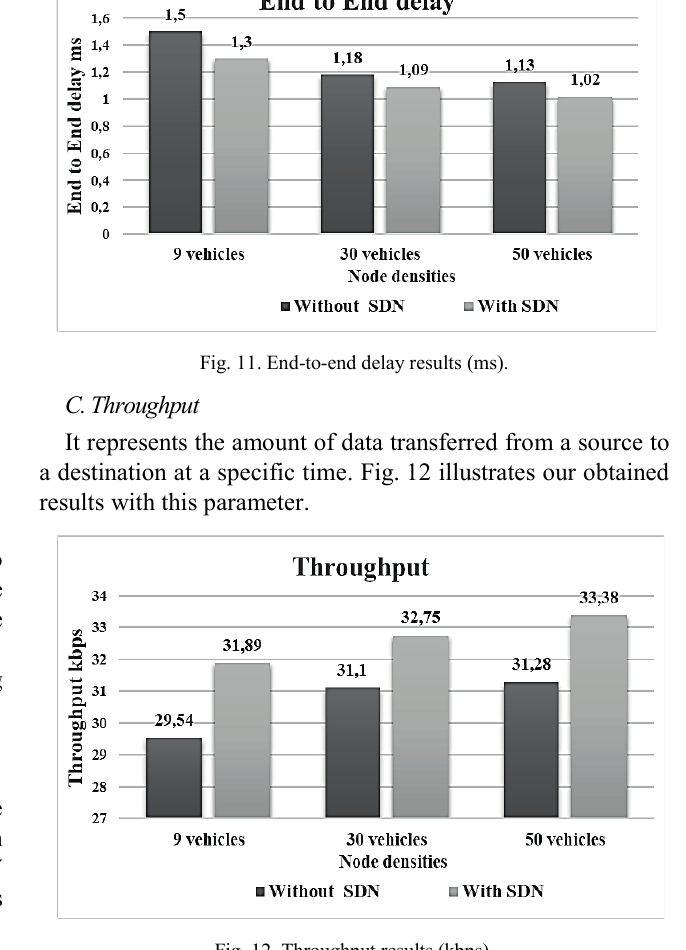
Fig. 12. Throughput results